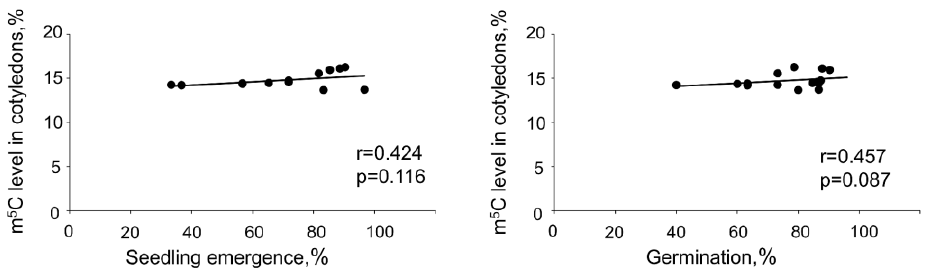
Figure 4. Spearman correlation coefficient analysis (r) between seedling emergence and global DNA methylation level in cotyledons, germination capacity, and global DNA methylation level in